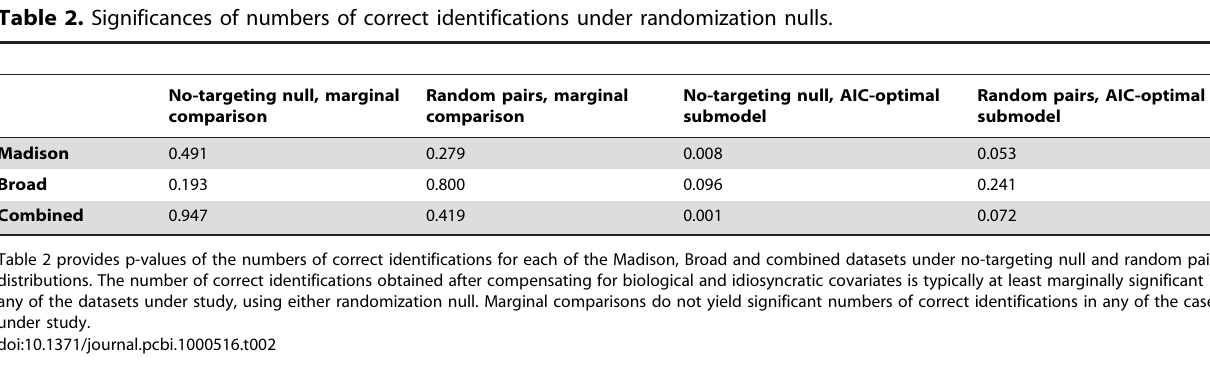
Table 2. Significances of numbers of correct identifications under randomization nulls.